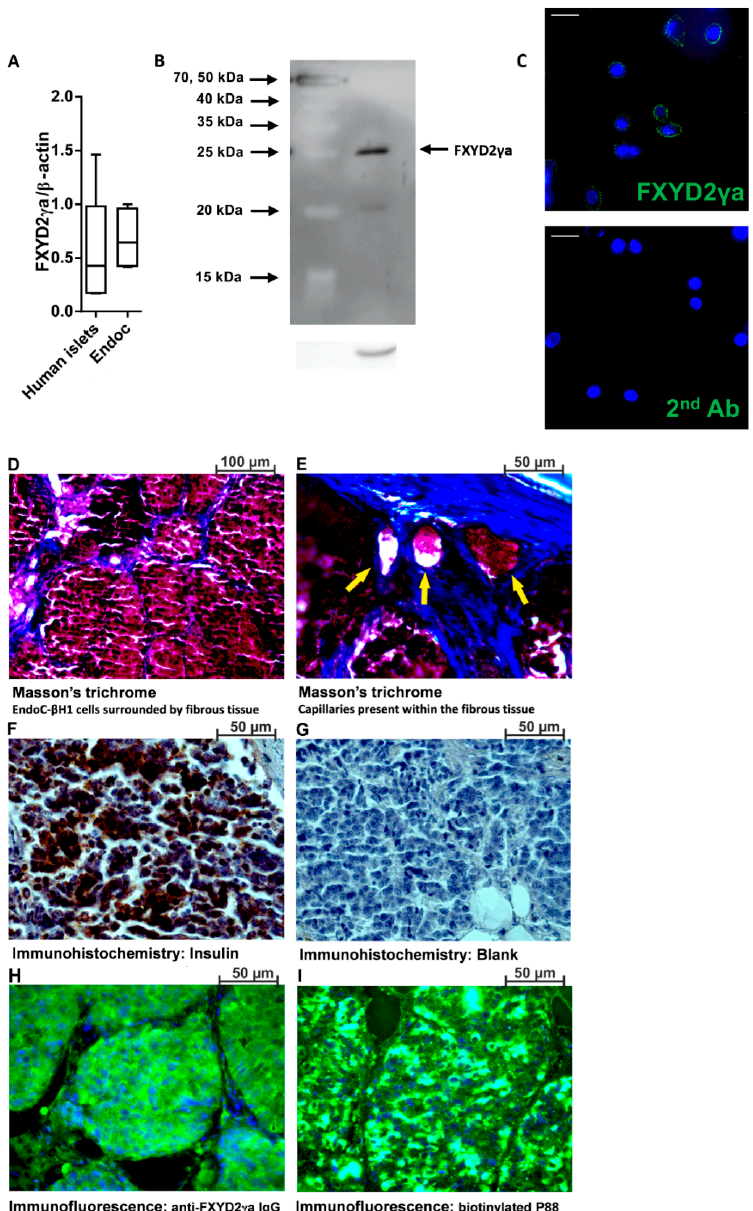
Figure 3. Expression of FXYD2 γ a in pancreatic human islets and EndoC- β H1 cells. ( A ) Quantitative RT-PCR (qPCR) of FXYD2 γ a mRNA expression in EndoC- β H1 cells ( n = 5) and human pancreatic islets ( n = 4). Data are presented as a box-plot. ( B ) A representative immunoblot of EndoC- β H1 cells, with alpha-tubulin as a reference protein ( n = 3); ( C ) Immunocytochemistry of EndoC- β H1 cells showing surface localization of FXYD2 γ a (green) and Hoechst staining of nuclei (blue) ( n = 3). The negative staining control of EndoC- β H1 cells (without the FXYD2 γ a antibody) is presented at the right side of panel C; the white scale bar represents 1 µ m. The luminosity and the contrast were uniformly increased in both pictures to improve visualization. The original pictures are shown in Figure S5 ( D – I ). Histological evaluation of the implanted EndoC- β H1 tumors, showing cells clustered into pseudo-islets surrounded by fibrotic tissue ( D ), capillary networks (yellow arrows) ( E ), insulin expression ( F ) with its corresponding negative control ( G ) and FXYD2 γ a detected with either SPY393 polyclonal antibody ( H ) or the biotinylated P88 ( I ); ( D – I ) are representative micrographs from 2 EndoC- β H1 cell-implanted